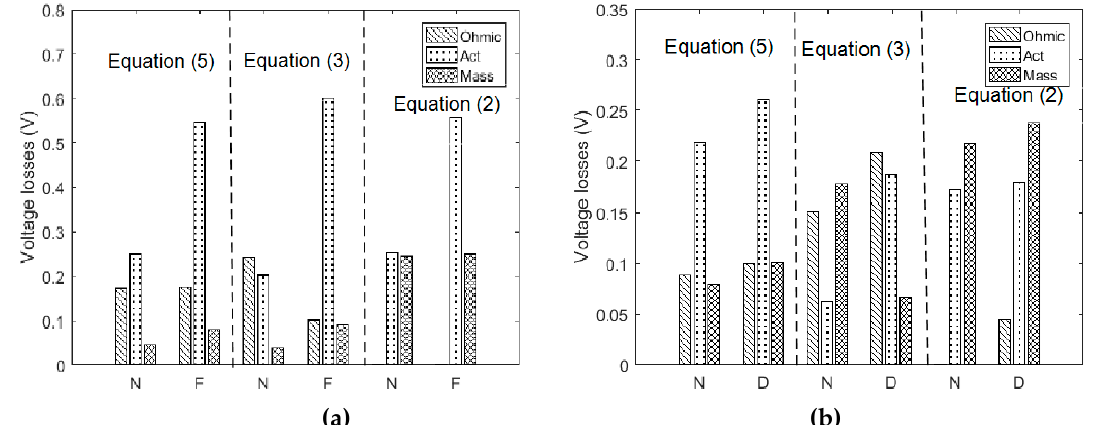
ff erent faults occur. ( a ) Flooding; ( b ) Figure 8. PEMFC losses before and after different faults occur. ( a ) Flooding; ( b ) Dehydration. Figure 8. PEMFC losses before and after di